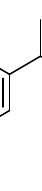
Figure 11. Salvicine.